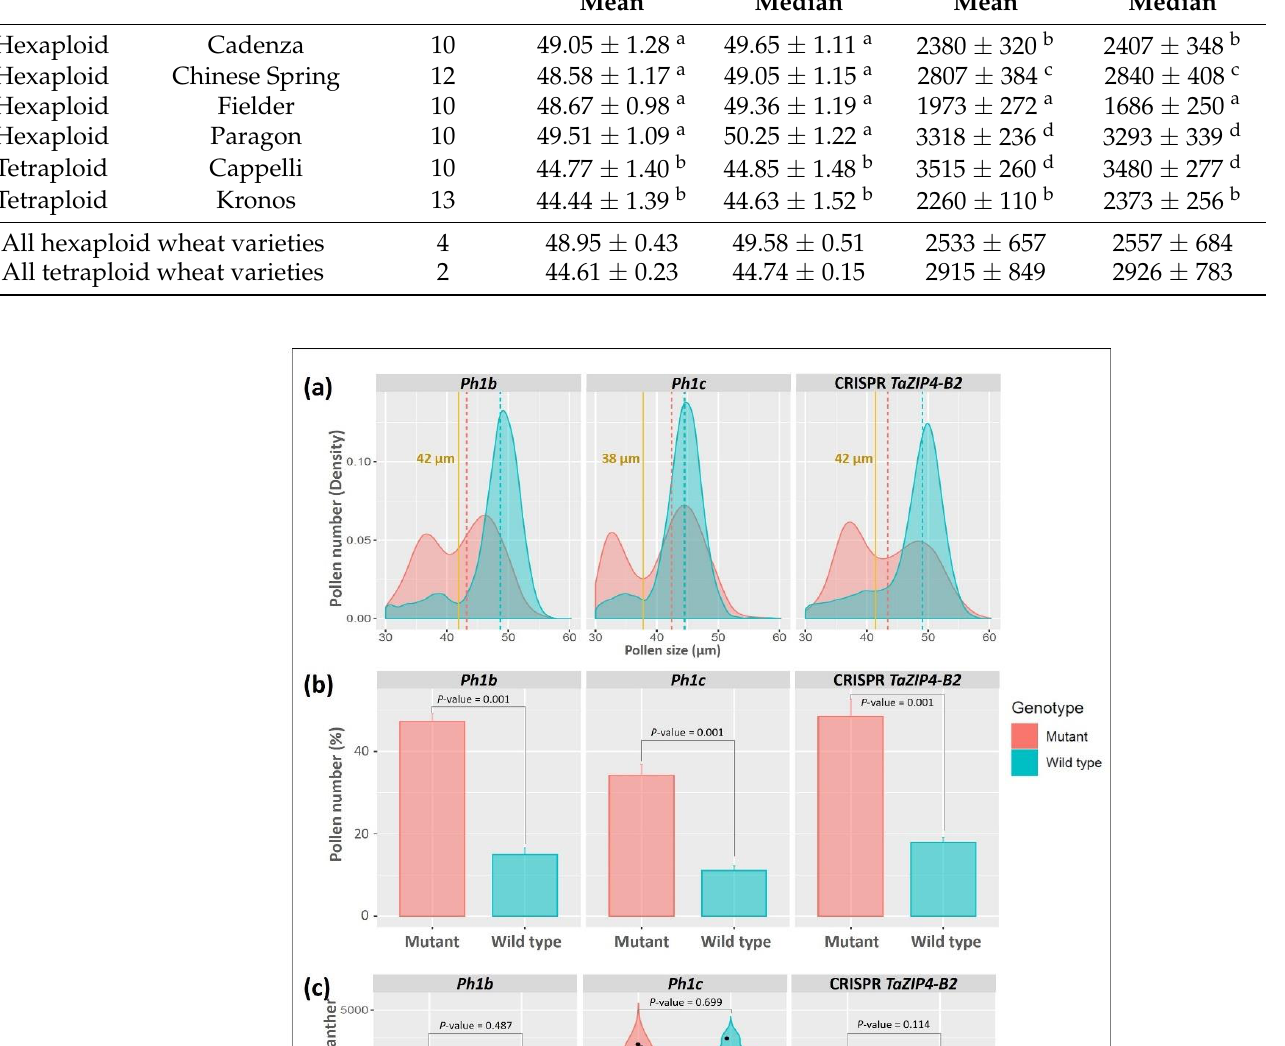
Table 4. Pollen number and pollen grain size for the three Tazip4-B2 mutants and their corresponding wild types. Mean and median values with standard deviations are shown. Treatments with the same letter are not significantly different.